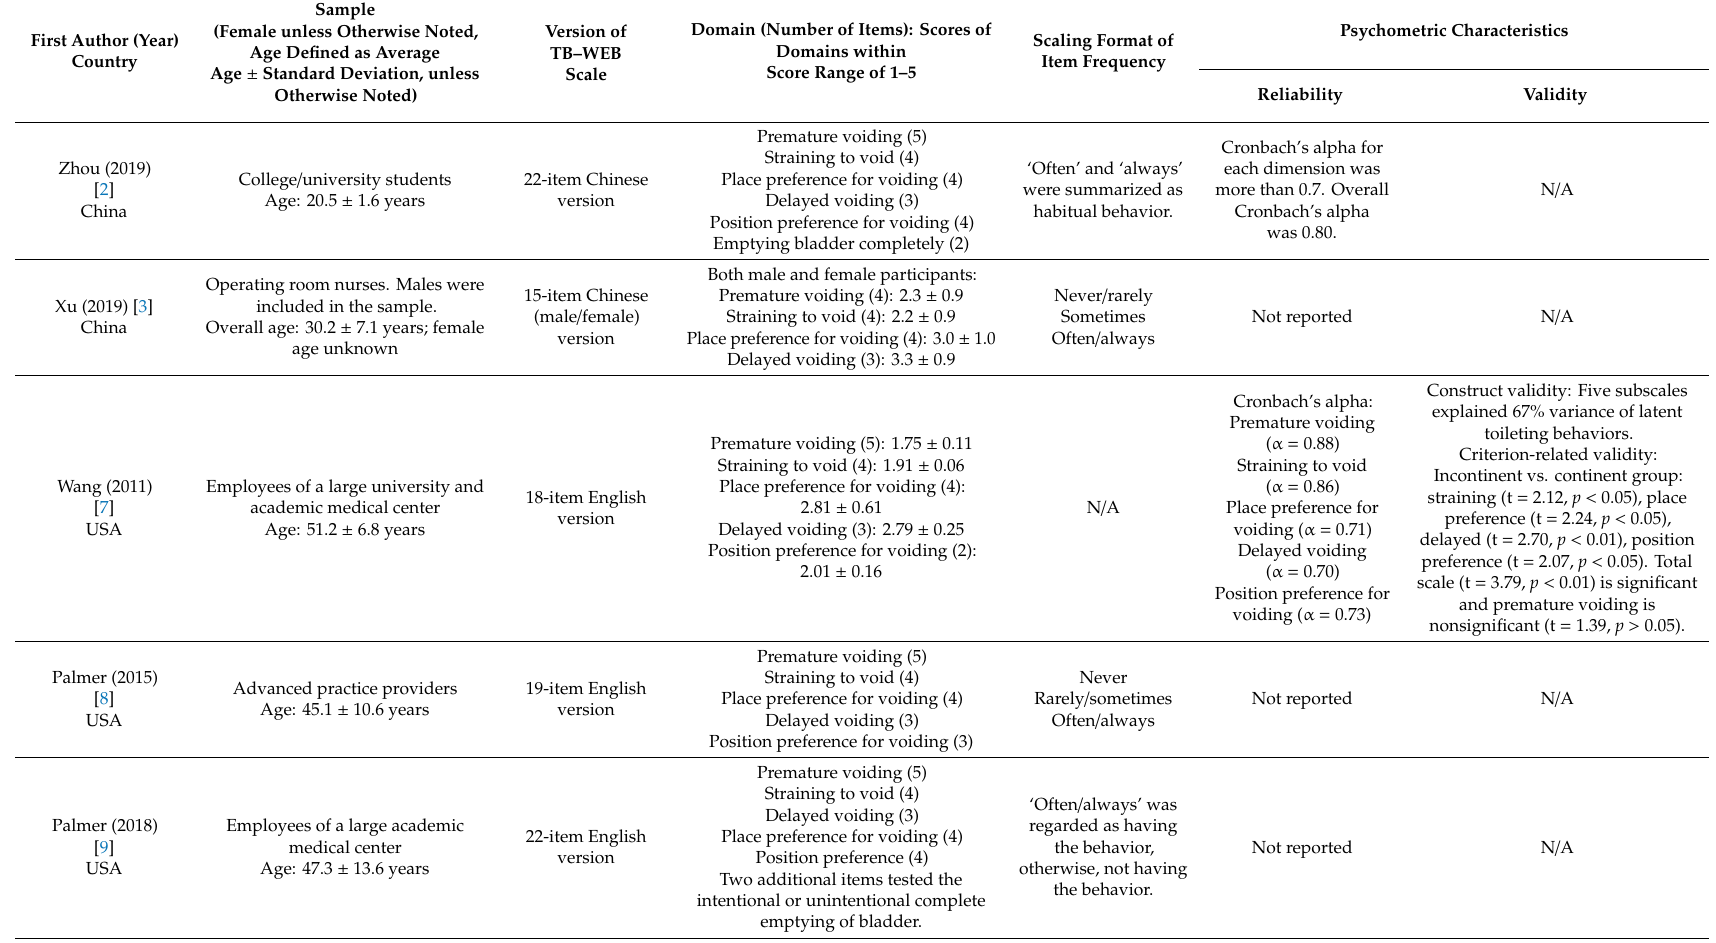
Table 1. Toileting Behaviors of Women, Measured Using TB–WEB Scale ( n =